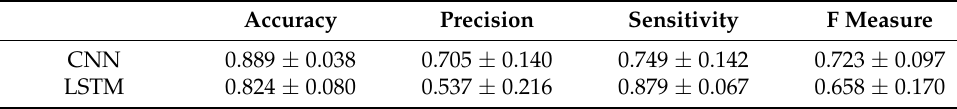
Table 3. Cross evaluation results for the two models.